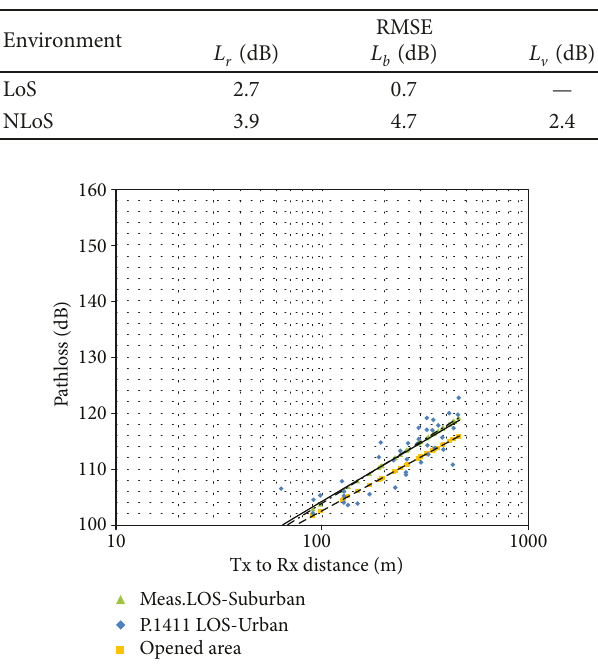
Figure 13: Pathloss characteristics according to the distance in LoS environment (at site-general).